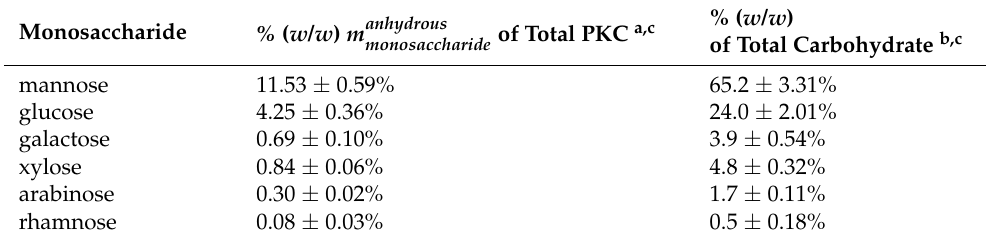
Table 1. The table gives the content of different monosaccharides in % of total PKC and % of total carbohydrate content as determined by total hydrolysis followed by quantitative 1 H-NMR spectroscopy.